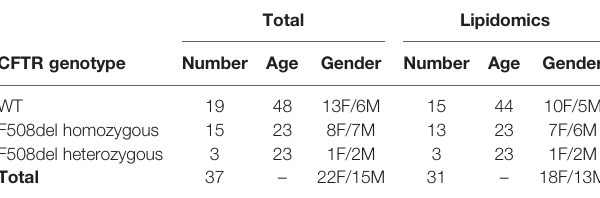
TABLE 1 | Donor ’ s